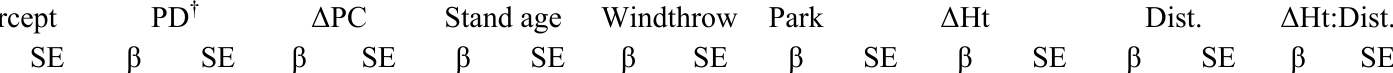
Table A2.3 Parameter estimates for models examining variation in stand-level trends (between circa 1994 and 2014) in abundance Swainson’s Thrush in aspen dominated mixedwood forests in central Saskatchewan. 85% Confidence Intervals can be obtained as β ± 1.44* SE. NOTE: Parameter values were rescaled by multiplying with a constant (100) for ease of presentation, divide by 100 to obtain